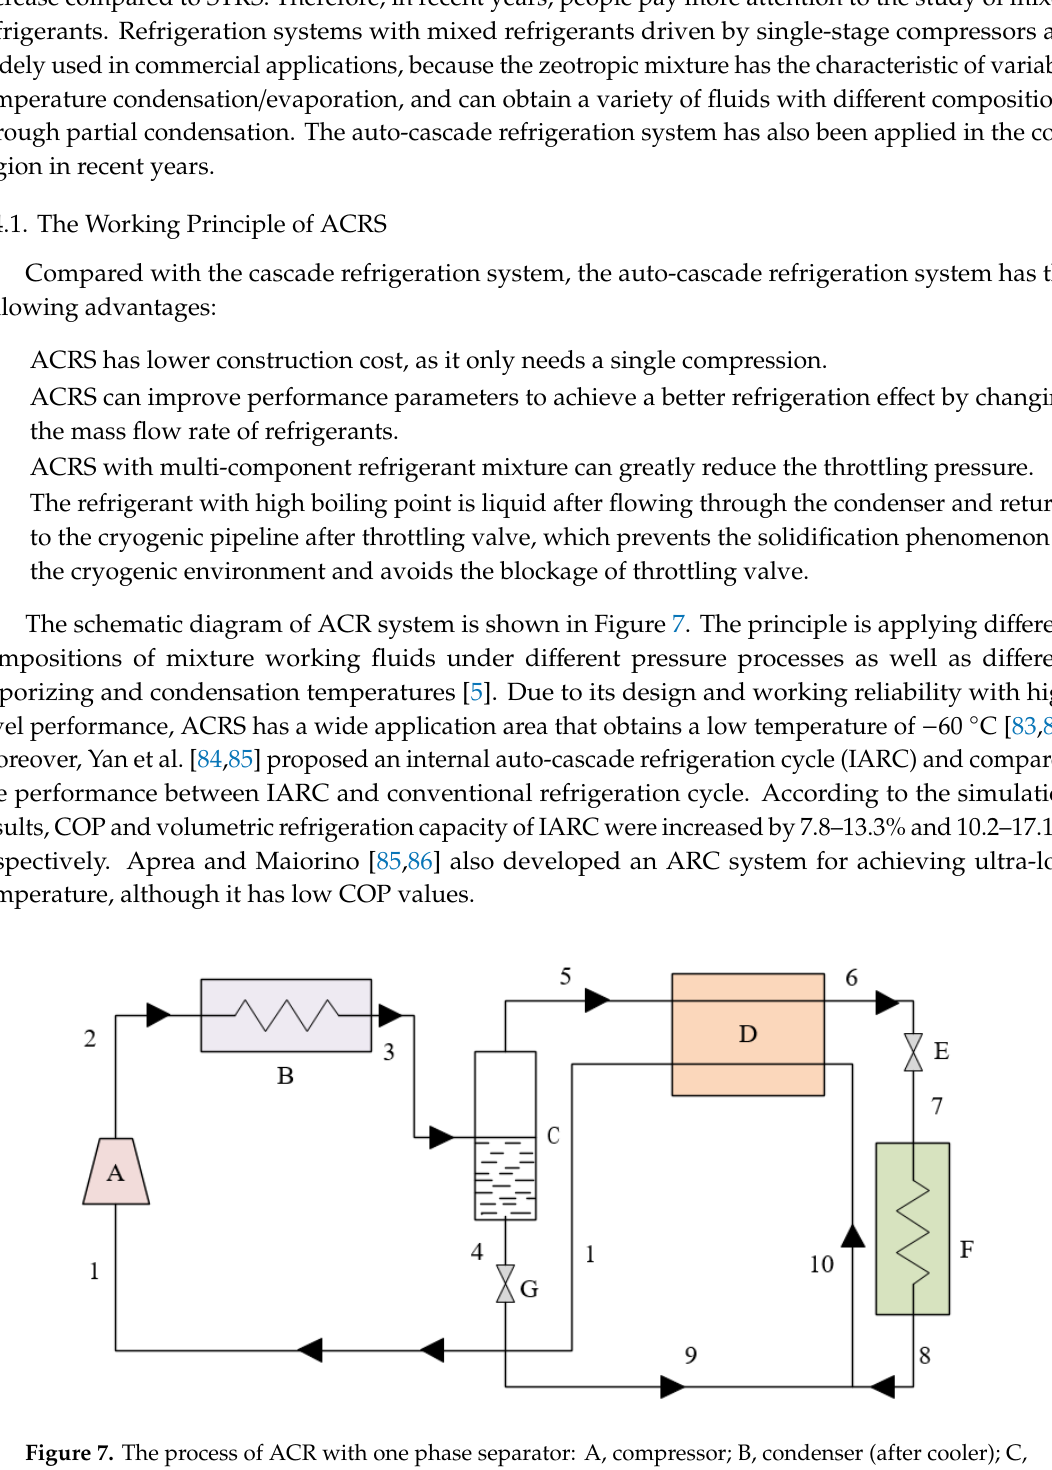
Figure 8. Schematic diagram of an auto-cascade absorption refrigeration system (ACARS) [87]. Reproduced with permission from [Elsevier], Elsevier, 2020. Scientists have investigated the performance of ACARS, which provides precooling at low temperatures for LNG liquefaction by utilizing low-grade thermal energy such as the waste heat of engine. The results show that, compared to an NH 3 -H 2 O absorption refrigeration system, ACARS at low refrigeration temperatures has more advantages for pre-cooling for LNG liquefaction [87]. 2.4.2. The Working Fluid in ACRS Because pure refrigerants have many limitations, causing poor performance, mixed refrigerants have been proposed, which may improve the performance of the refrigeration system and reduce the limitations of pure refrigerants. Mixed refrigerants are composed of two or more pure refrigerants in a certain proportion. We can obtain the desired thermodynamic properties of fluids by adjusting the